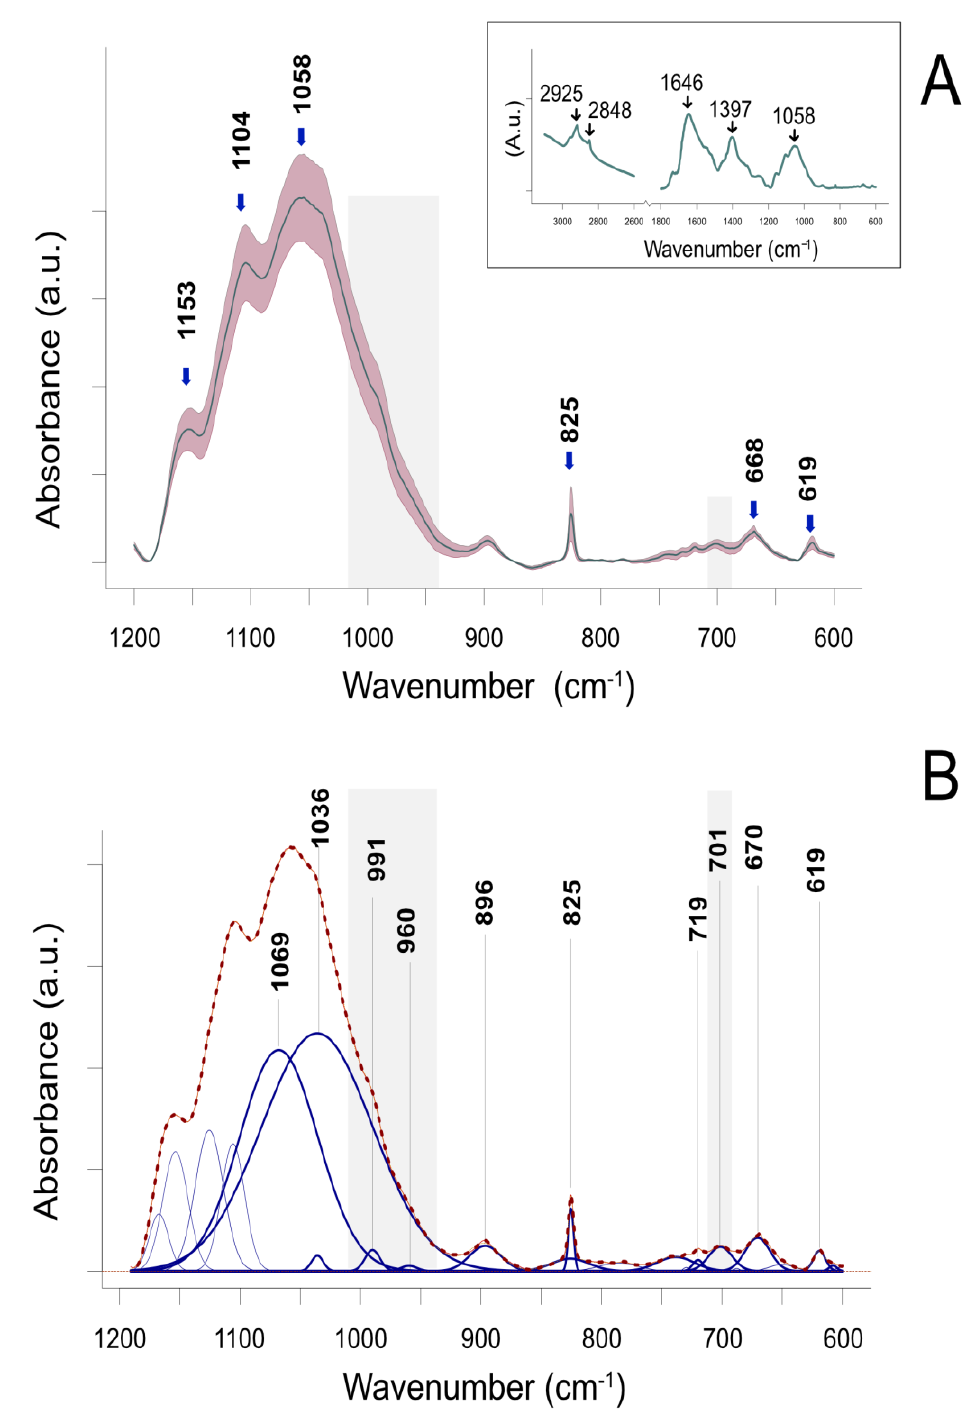
Figure 1. Attenuated Total Reflectance Fourier Transform Infrared (ATR-FTIR) spectrum of the leaves of barley plants regenerated by an in vitro anther culture. ( A ) ATR-FTIR spectra of the region between 1200 and 600 cm − 1 . The most prominent peaks are marked. The inset presents an extended range of the spectrum between 3100 and 600 cm − 1 . Data represent mean ± standard deviation (SD). ( B ) Numerical (Gaussian) deconvolution of overlapping peaks. Data represent the sum of fitted curves (dashed line) closely overlapping the experimental data (solid red line). The centered frequencies of major resolved peaks are shown in blue. Regions shaded in gray represent spectral regions relevant to mediation analysis.